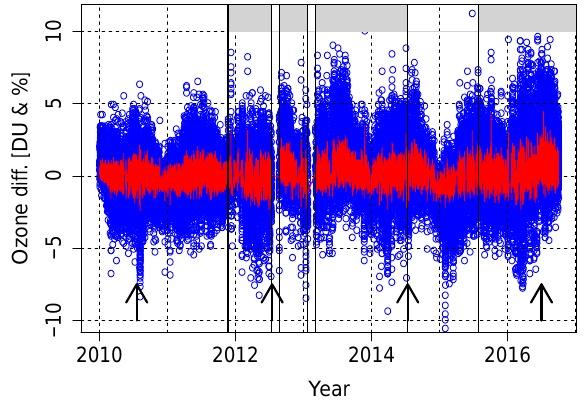
Figure 3. Time series of the differences between coincident mea- surements of the Brewer instruments B 040 and B 072 over the period 2010–2016. Blue: difference in DU units. Red: difference in [%]. The arrows indicate the calibration campaigns and the gray-shaded areas denote the periods when Brewer instrument B 072 was operat- ing in